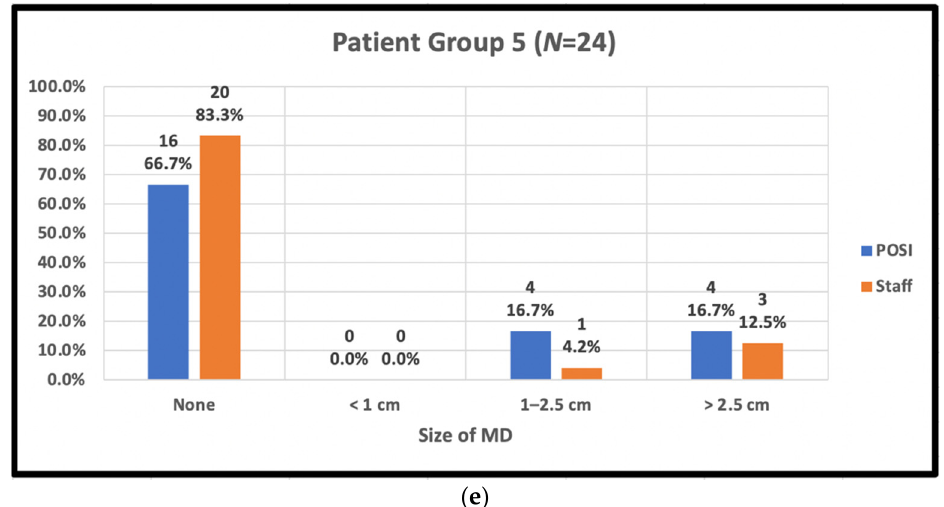
Figure 3. Peak skin moist desquamation (MD) scores reported by staff and in POSI questionnaires by body type. ( a ) Patient body group 1: BMI < 25, cup A–C, IMF < 1 cm; ( b ) patient body group 2: BMI ≥ 25, cup ≥ D, IMF ≥ 1 cm; ( c ) patient body group 3: BMI < 25, Cup ≥ D, IMF ≥ 1 cm; ( d ) patient